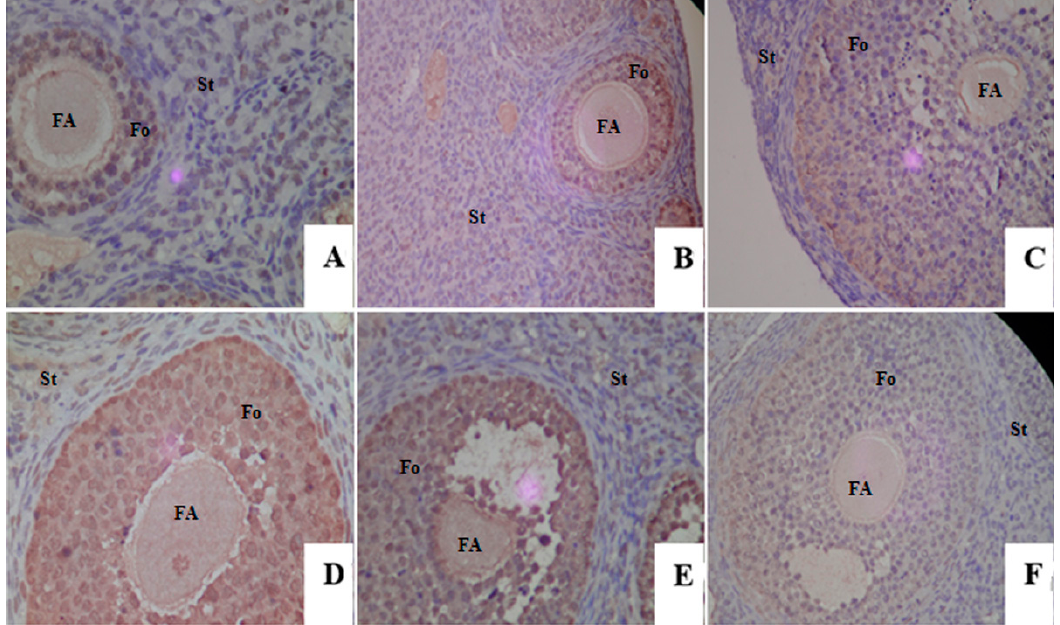
Figure 3. Photomicrograph of PCNA from growing follicles in each group. ( A ) Control group; ( B ) model group; ( C ) estradiol group; ( D ) low-dose genistein group; ( E ) moderate-dose genistein group; ( F ) high-dose genistein group. The expression of PCNA-positive was brown in color, while blue in color for PCNA-negative expression. Original magnification 400×. Fo: follicle; St: stroma; FA: follicle antrum.